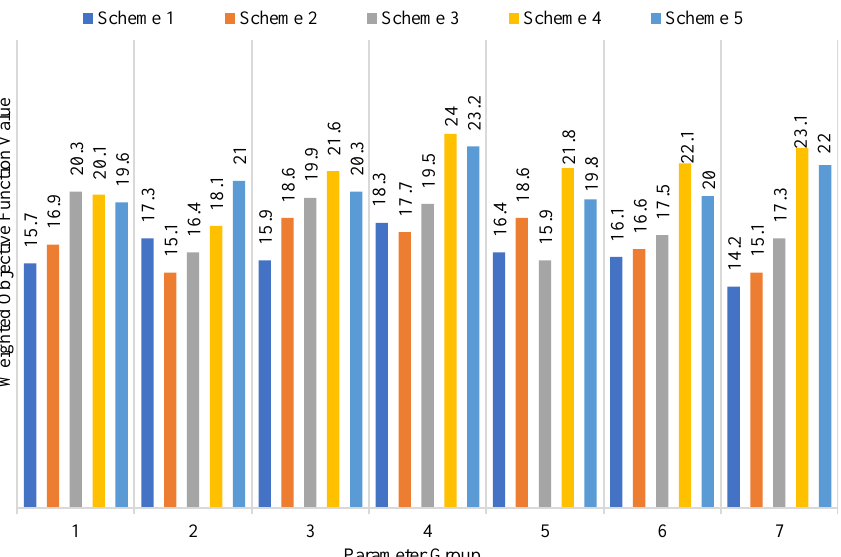
Figure 6. Comparison of weighted comprehensive costs with different